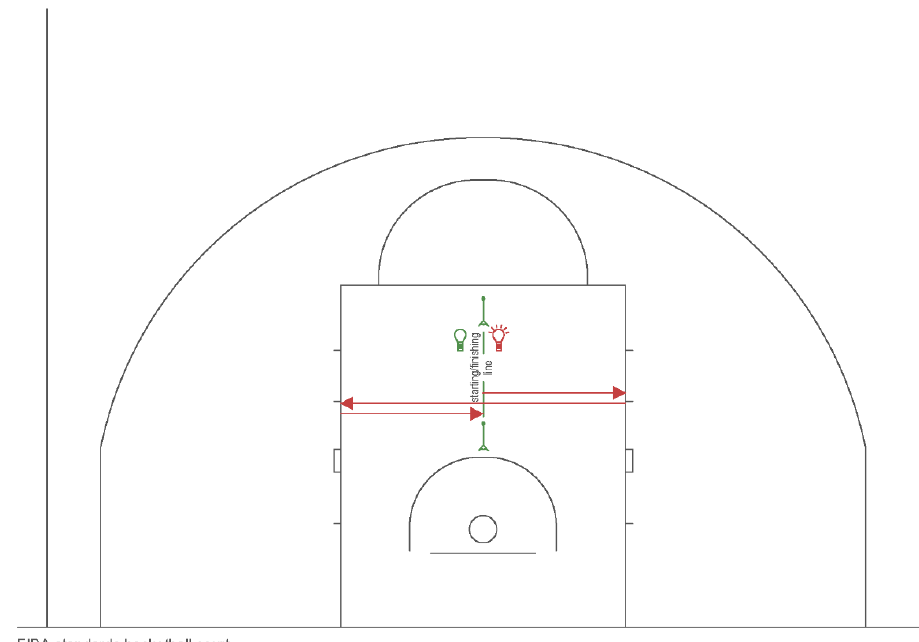
Figure 6. The trajectory of the Lane Arrow Closeout Test. Adapted and edited from the article by Stojanović et al. [18] from which the full description of the test can be found.